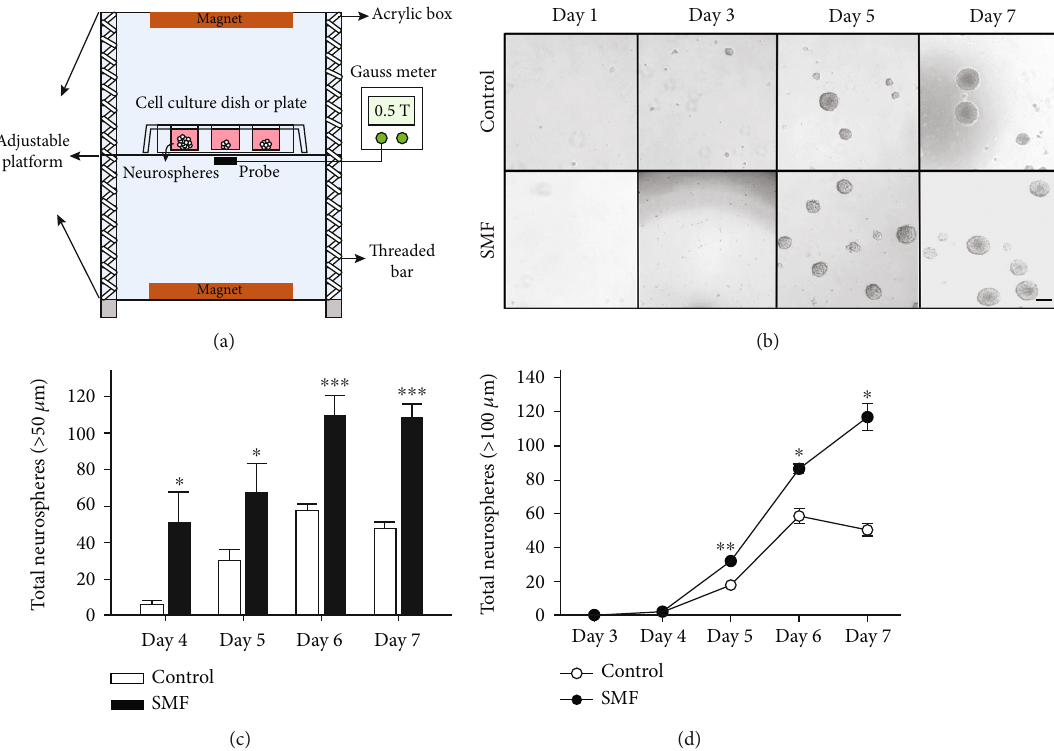
Figure 1: SMF stimulates the proliferation of mNPCs. Neurospheres developed from the neurosphere assay of control and SMF group. (a) Schematic drawing of the experimental device. (b) Typical phase-contrast micrographs. Scale bar, 100 μ m. (c) Neurosphere numbers per well developed from 4, 5, 6, and 7 day cultures. The number of neurospheres is signi fi cantly increased under SMF exposed. (d) Neurosphere numbers per well at sizes ( > 100 μ m) developed from 3-7 day cultures. Data represent the mean ± S : E : M : ; control, n = 5 ; SMF, n = 3 ; ∗ p < 0 : 05 , ∗∗ p < 0 : 01 , ∗∗∗ p < 0 : 001 ; Student ’ s t